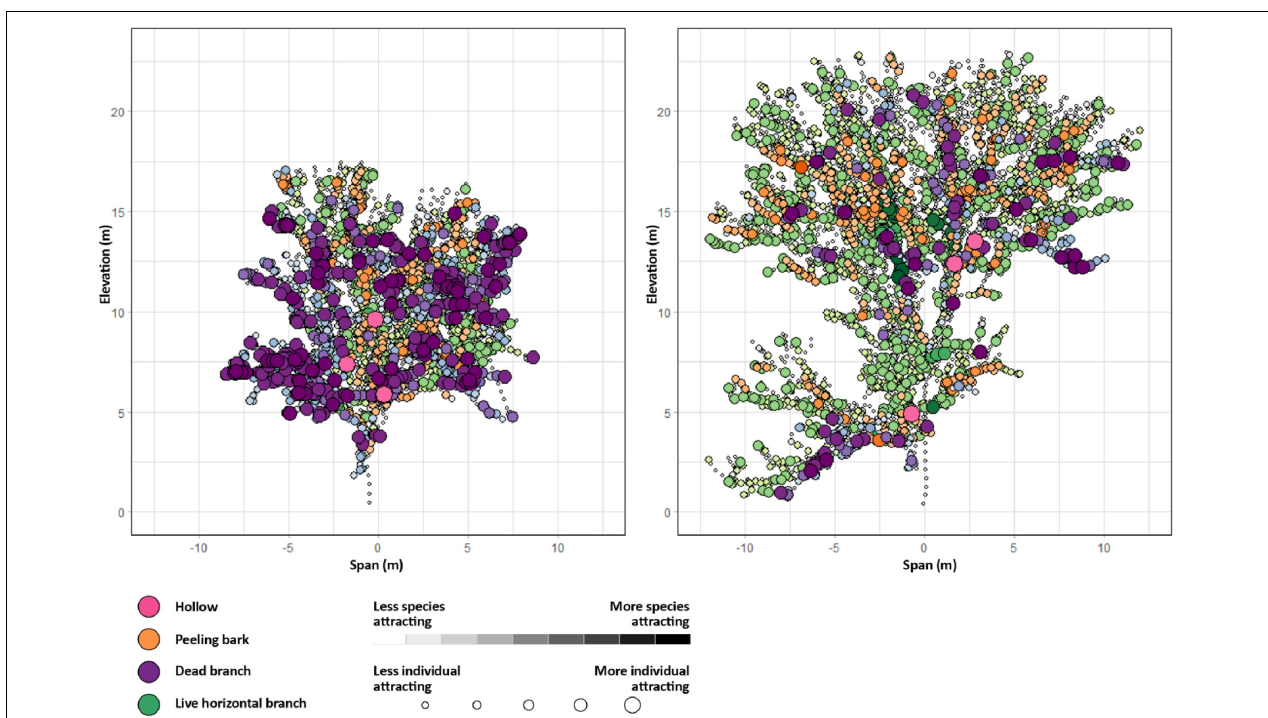
FIGURE 10 | Two large old trees from the full version of our